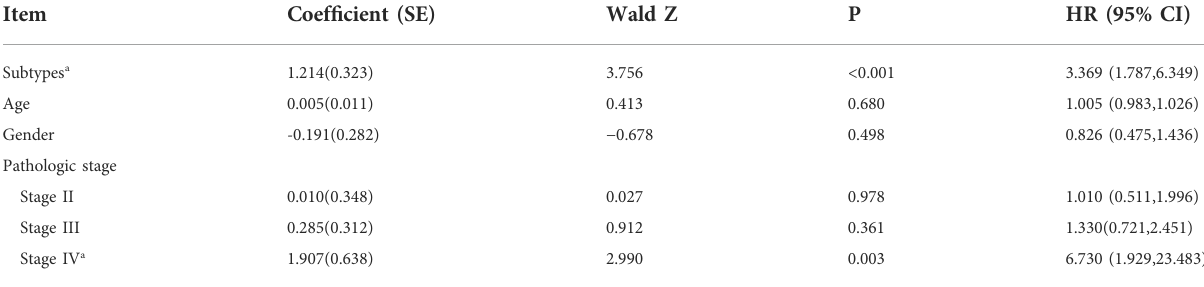
TABLE 2 Results of Cox regression analysis in 287 patients with